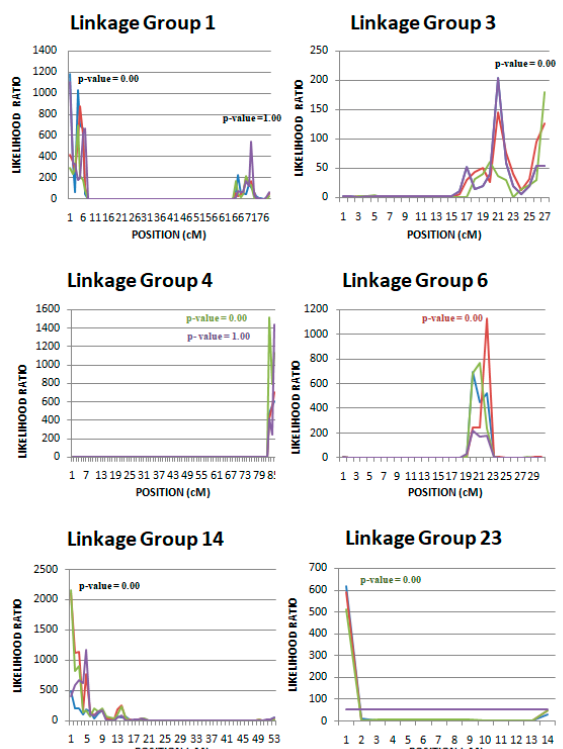
Figure 3. QTL analysis (using a mixed model which includes a polygenic component) of body weight at 290-306 DPH (bwt1), 318-334 DPH (bwt2), 346-362 DPH (bwt3), and 362-378 DPH (bwt4) in different linkage groups. Blue, red, green, and purple lines represent likelihood ratios of bwt1, bwt2, bwt3, and bwt4, respectively. Blue, red, green, and purple p -values represent significance of bwt1, bwt2, bwt3, and bwt4, respectively. Black color represents significance of all body weights.